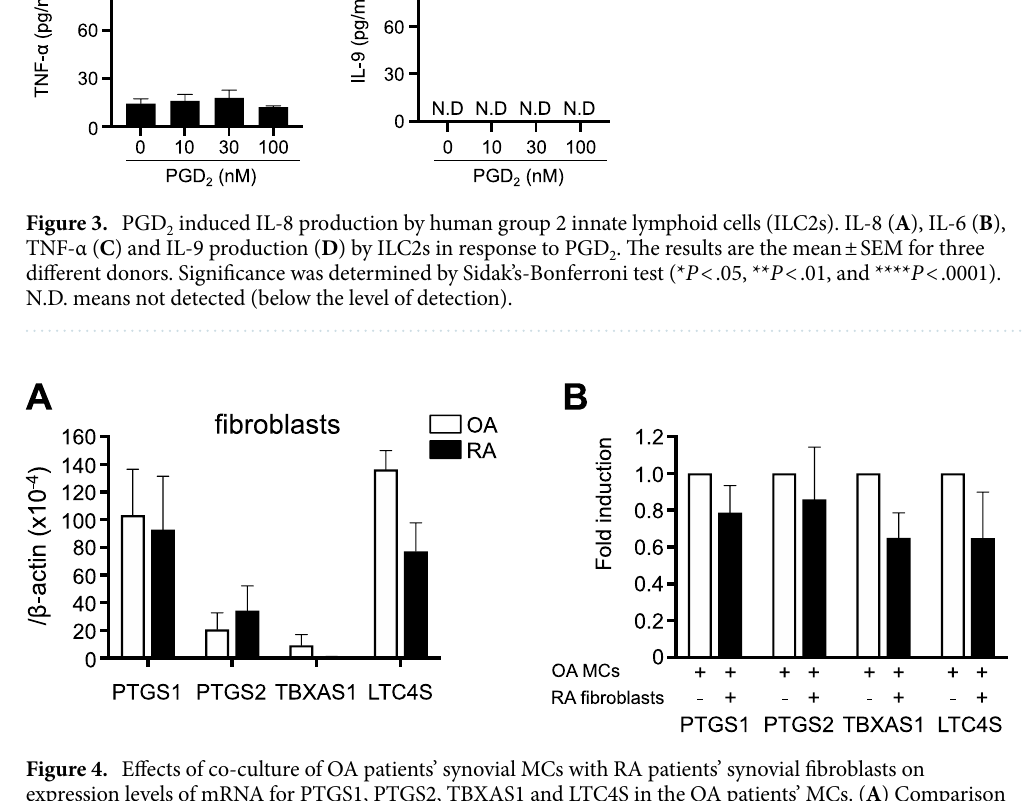
Figure 4. Effects of co-culture of OA patients’ synovial MCs with RA patients’ synovial fibroblasts on expression levels of mRNA for PTGS1, PTGS2, TBXAS1 and LTC4S in the OA patients’ MCs. ( A ) Comparison of expression levels of mRNA for PTGS1, PTGS2, TBXAS1 and LTC4S in fibroblasts obtained from OA (open bars, n = 4) and RA (closed bars, n = 4) patients. The data are shown as the ratio of the enzyme mRNA level to the β-actin mRNA level (× 10 –4 , mean ± SEM). ( B ) Effects of co-culture of OA patients’ synovium-derived, cultured MCs (n = 5) with RA patients’ fibroblasts (n = 2) on expression levels of mRNA for PTGS1, PTGS2, TBXAS1 and LTC4S in the OA patients’ MCs. The data are shown as the ratio of the enzyme mRNA level in the MCs alone to that in the MCs after co-culture with the RA patients’ fibroblasts (mean ±